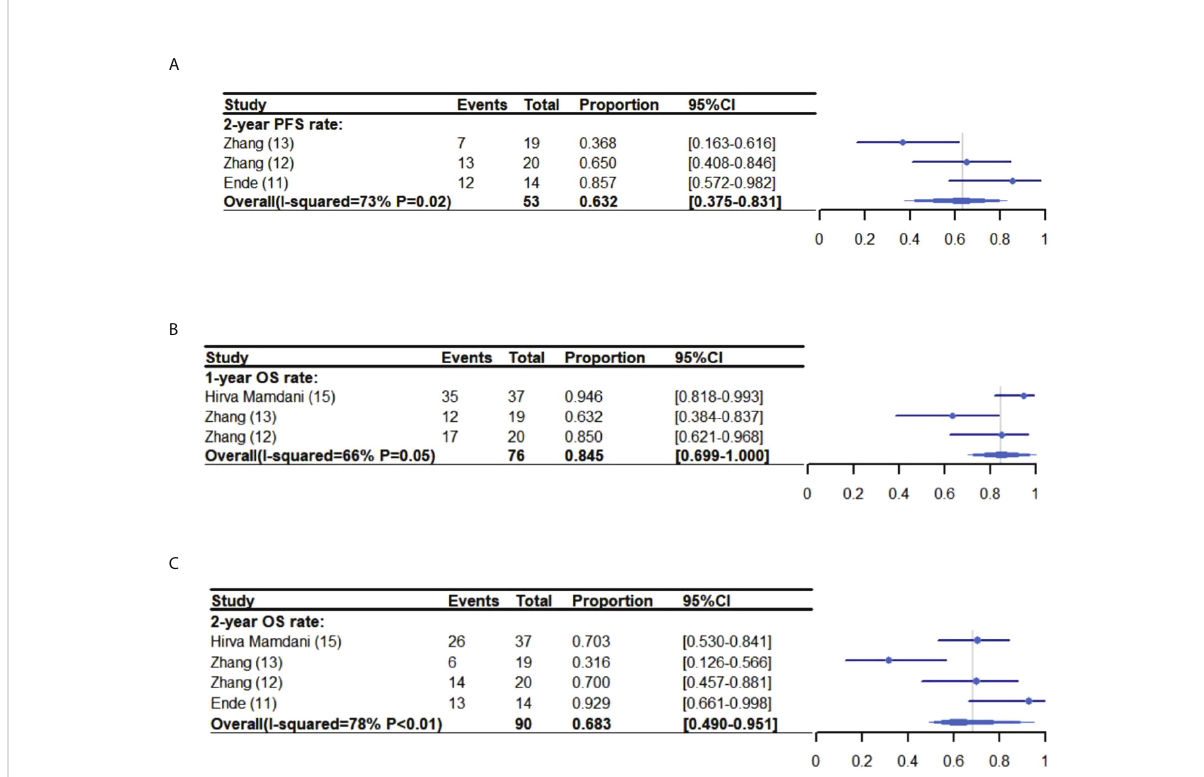
FIGURE 2 One-year PFS meta-analysis and forest plot (A) , one-year OS (B) and two-year OS (C) for esophageal cancer patients treated with ICIs and CRT/ RT. PFS, Progression free survival; OS, Overall survival; ICIs, Immune checkpoint inhibitors; CRT, Chemoradiotherapy; RT,